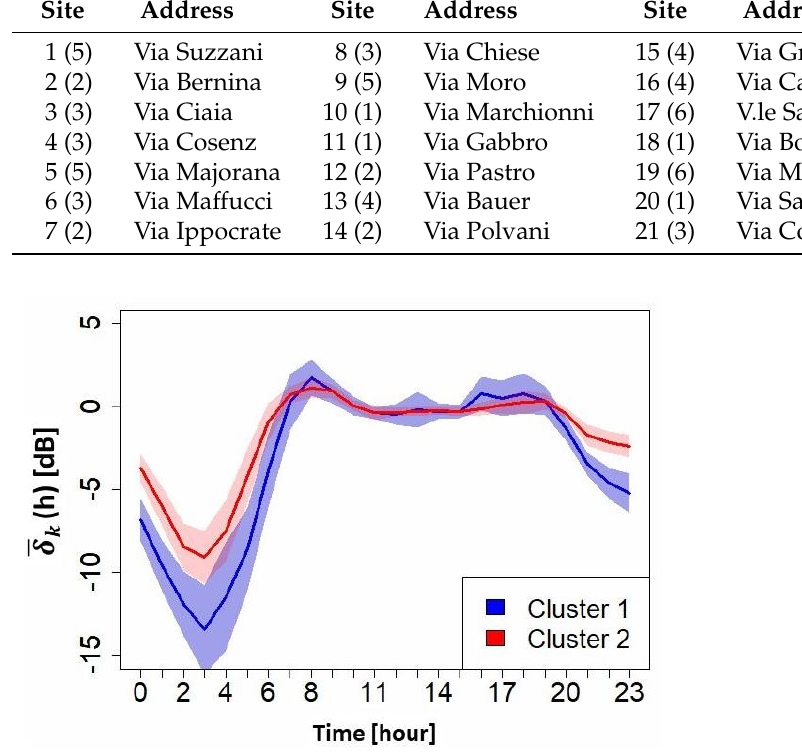
Figure 7. Mean normalized hourly cluster profiles, δ k ( h ) [dB], vs. day hour h , from the 24 Dynamap sensors (see Equation(12)). Here, k = 1,2 indicates the cluster index. The corresponding ± standard deviations are indicated by the colored bands [91]. Notice the shift of the time axis with respect to Figure